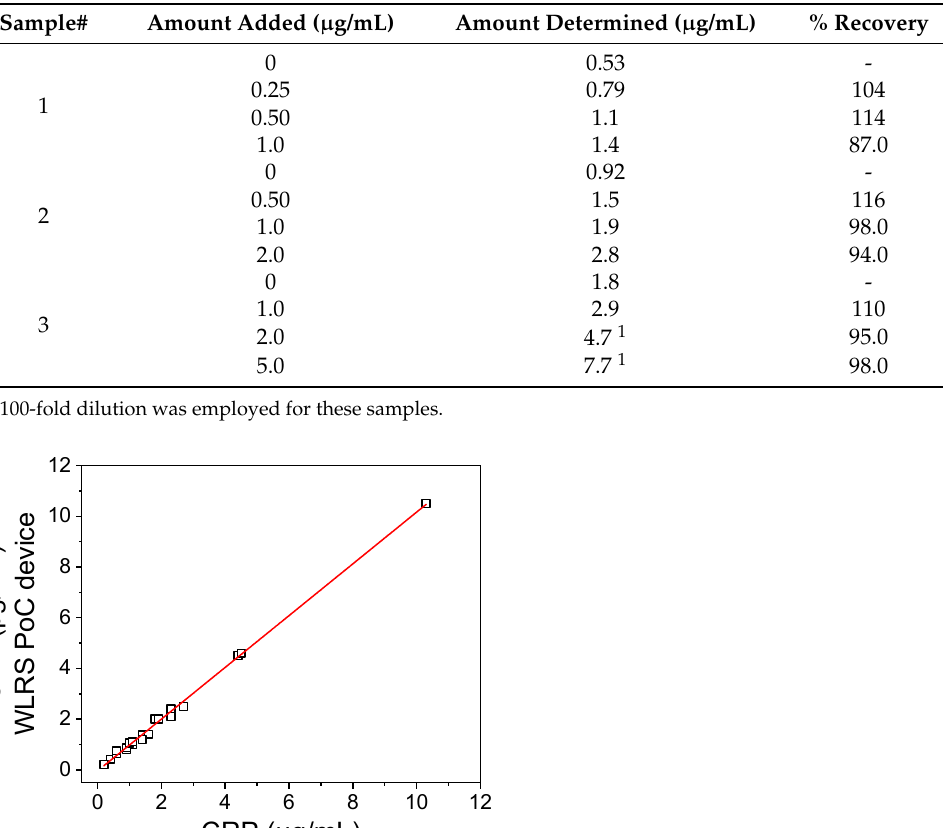
Table 1. Percent recovery values of exogenous added CRP to three human plasma samples.